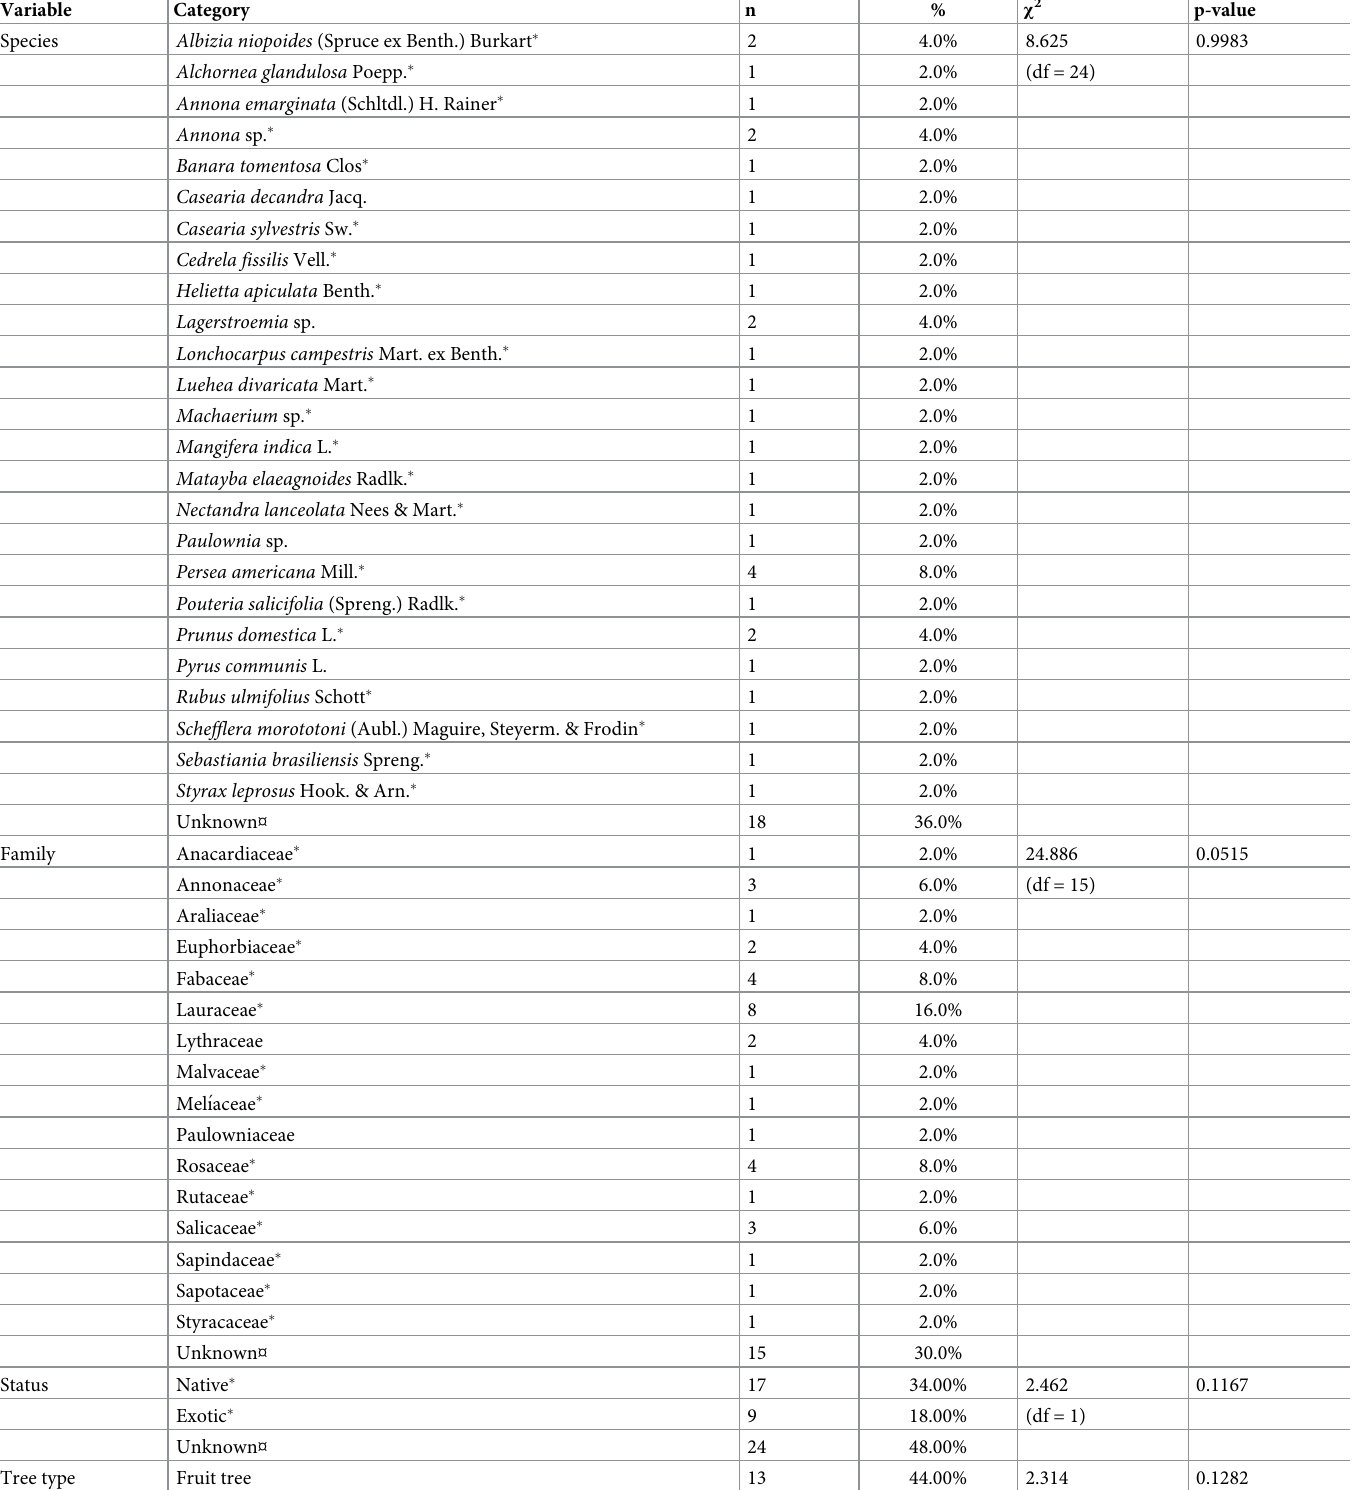
Table 3. Host plants (n = 50) for Lonomia larvae in Misiones, Argentina. Variable Category